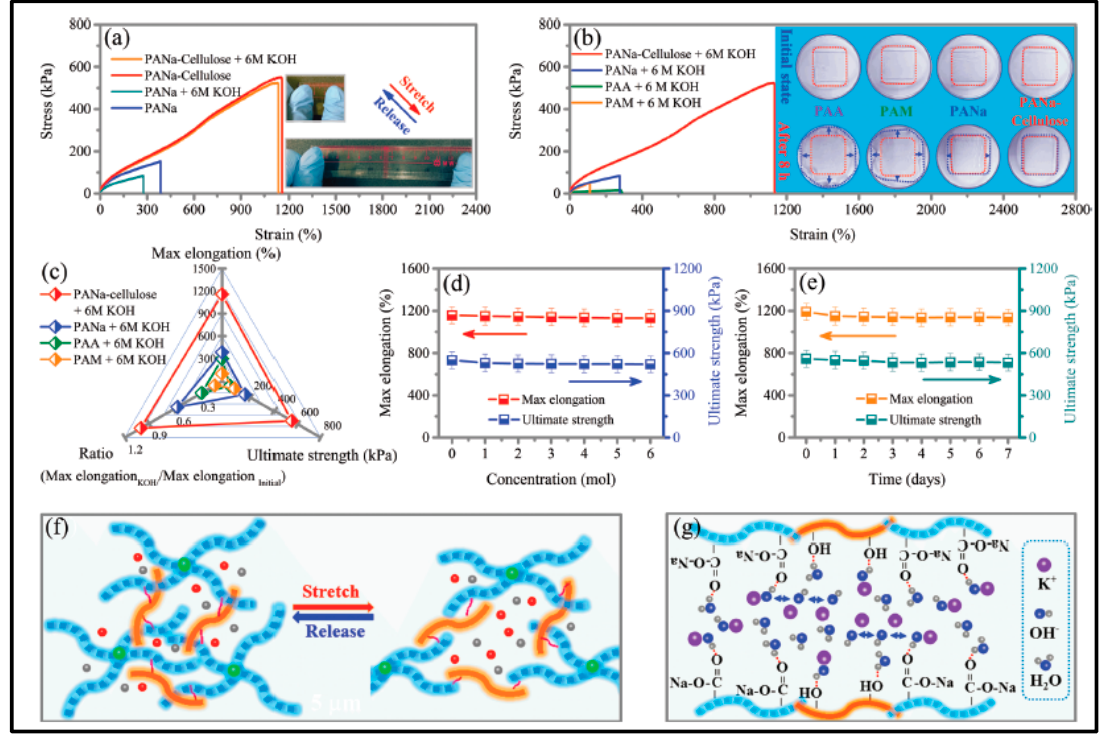
Figure 14. ( a ) Tensile stress versus strain curves of the as-synthesized PANa and PANa-cellulose hydrogel electrolyte with and without 300% 6 M KOH + 0.2 M Zn(CH 3 COO) 2 intake. The insets are optical photos of the relaxed and elongated states of the 300% 6 M KOH + 0.2 M Zn(CH 3 COO) 2 solution incorporated PANa-cellulose hydrogel electrolyte showing excellent stretchability. ( b ) Comparison of tensile properties of PAA, PAM, PANa and PANa-cellulose hydrogel under alkaline condition. The inset is the photos of PAA, PAM, PANa and PANa-cellulose hydrogel at initial state and containing 300% 6 M KOH solution for 8 h. The red and blue rectangle represent the shape of hydrogel before and after infiltrating alkaline solution. ( c ) Comparison of alkaline-tolerant capability of different hydrogel electrolyte. ( d ) Ultimate strength and maximum elongation of PANa-cellulose hydrogel electrolyte containing KOH solution with different concentrations. ( e ) Ultimate strength and maximum elongation of PANa-cellulose hydrogel electrolyte containing 300% 6 M KOH solution after different alkaline corrosion times. ( f ) Schematic illustration for origin of ultra-stretchability. ( g ) Schematic diagram reflecting structure of PANa-cellulose hydrogel electrolyte entrapped KOH and water via the interactions of hydrogen bonds.Reproduced with permission from [273]. Copyright 2019 Wiley.